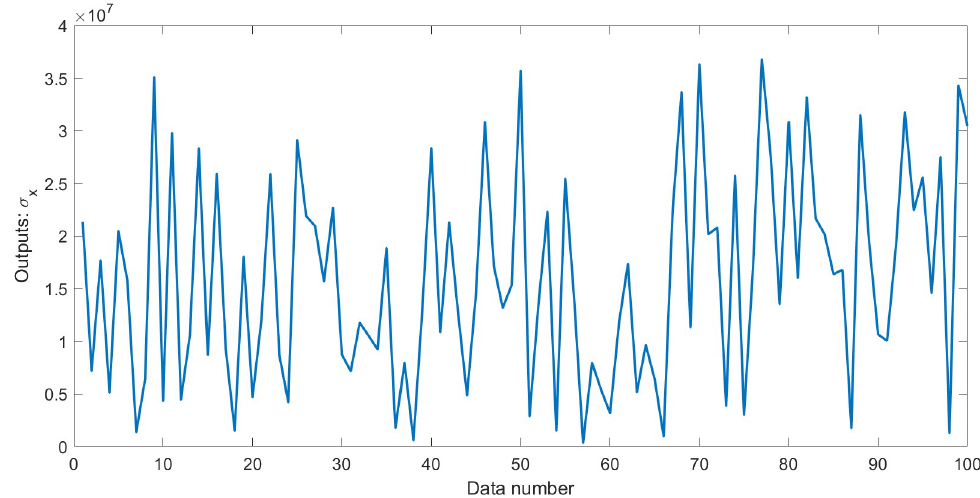
Fig 5. Outputs σ